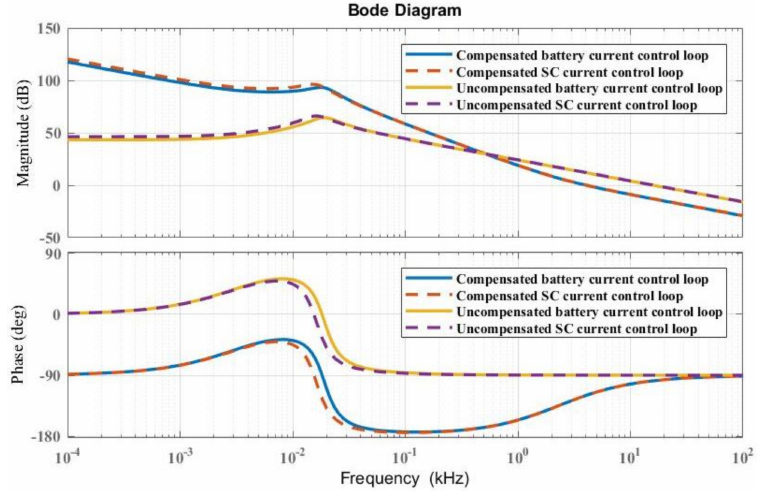
Figure 11. Bode plot of the compensated and uncompensated current control loop for battery and